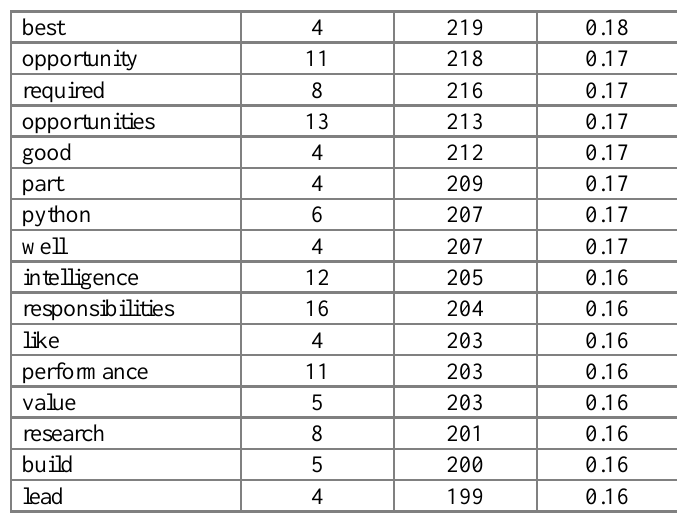
Figure 1: Word Cloud of the 100 Most Common Words